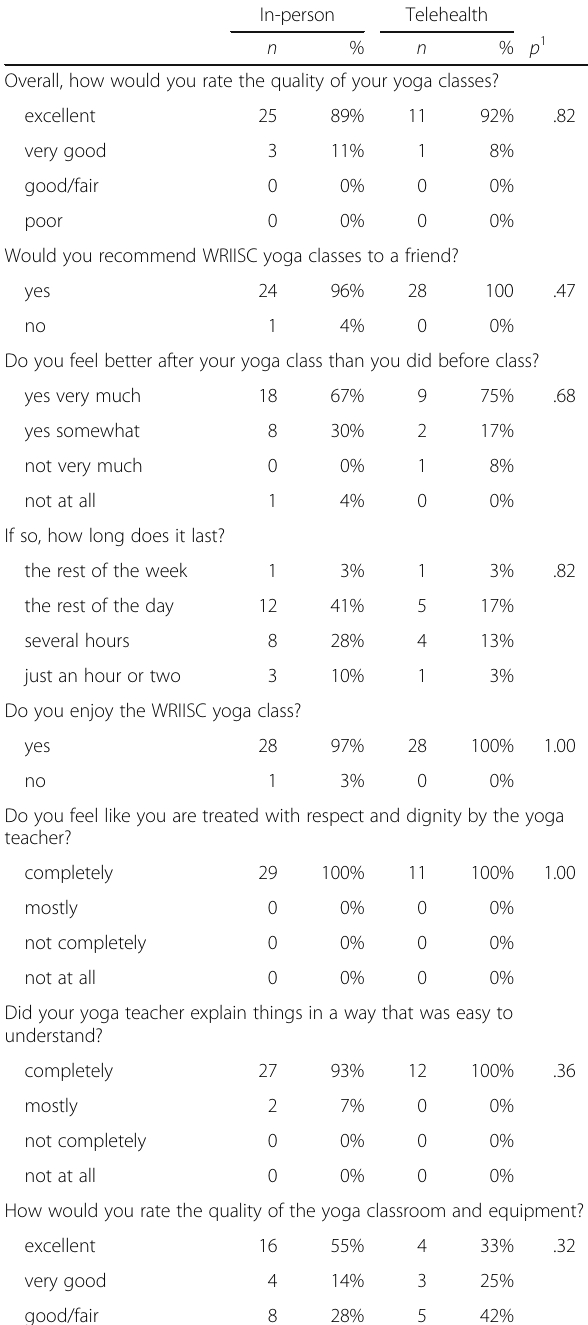
Table 4 Satisfaction In-person Versus